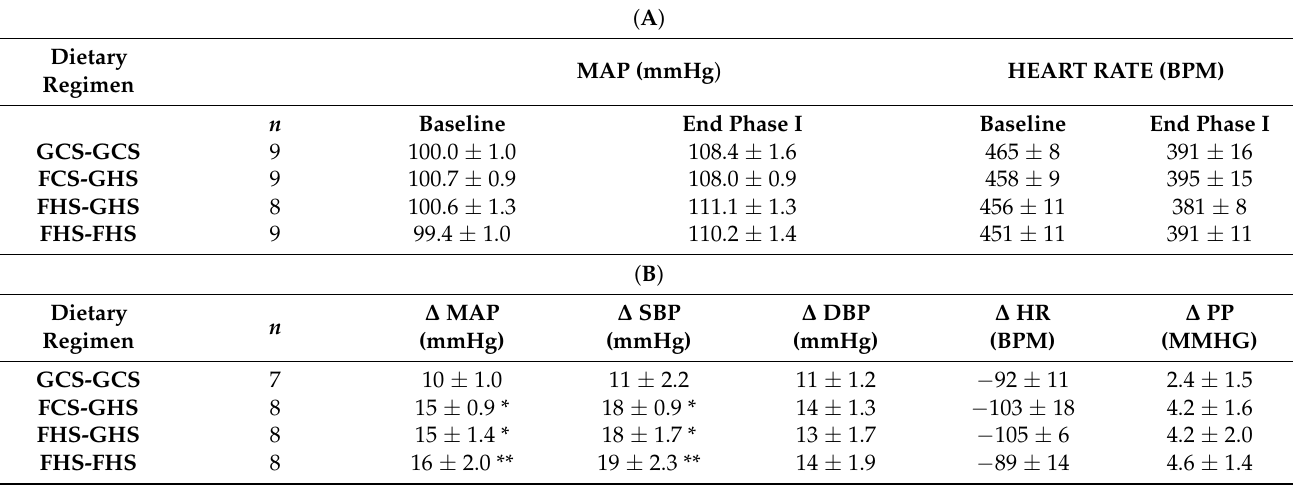
Group names as in Table 1. Values are the mean ± SE, n as indicated per group. ( A ) Mean arterial pressure (MAP) and heart rate (HR) at baseline and at the end of Phase I. ( B ) Study-wide changes in hemodynamics calculated as the difference between measurements taken at the end of Phase III and baseline values at the beginning of Phase I. Values are the mean ± SE, n as indicated per group. * p < 0.05 vs. GCS-GCS; ** p < 0.01 vs. GCS-GCS.